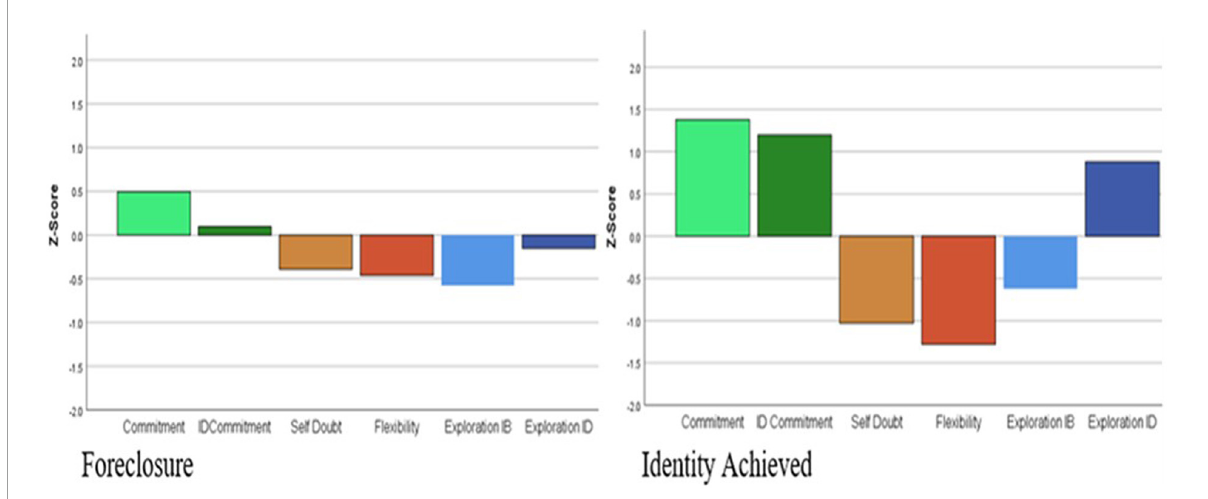
FIGURE3 Profiles for advanced (foreclosure and identity achieved) identity statuses.